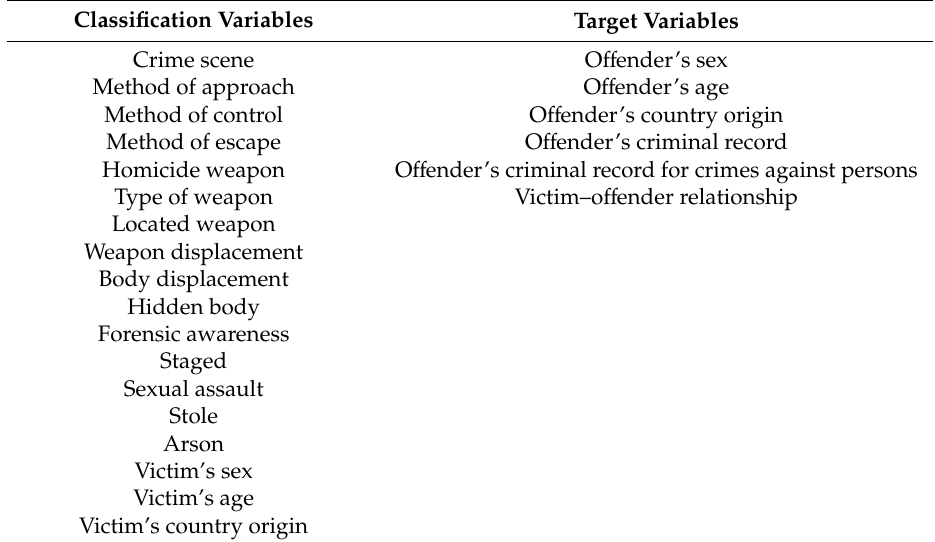
Table 1. Variables used in the classification